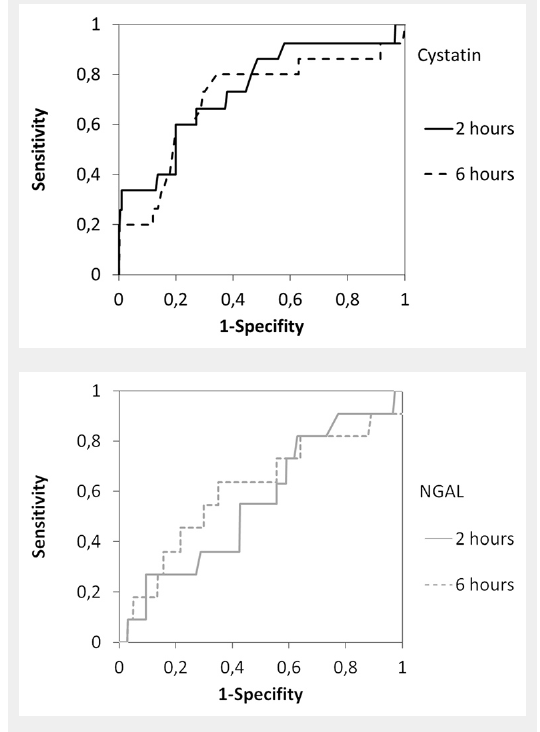
Receiver operating characteristic (ROC) curve analysis using 2h and 6h postoperative serum Cystatin C (a) and urine NGAL (b) concentration in the patient cohort. The area under the ROC curve for Cystatin C was 0.74 (2h; p = 0.003) and 0.71 (6h; p = 0.009), respectively. The area under the ROC curve for urine NGAL was 0.56 (2h; n.s.) and 0.60 (6h; n.s.). Optimal sensitivity and specifity occurred at a value of 0.995 mg/l for 2h Cystatin C.